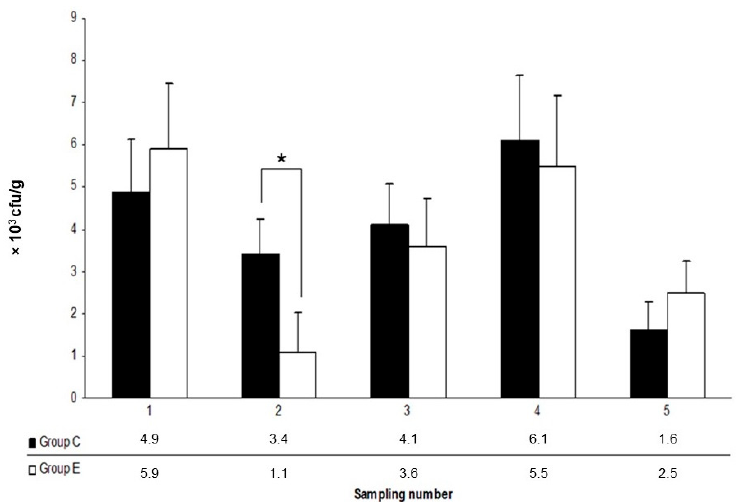
Figure 2. Differences in Campylobacter spp. number during the experiment (*— p -value ≤ 0.05). Samples were collected at 20-day intervals (number of measurements n = 5; 1—2 January, 2—22 January, 3—11 February, 4—3 March and 5—21 March).